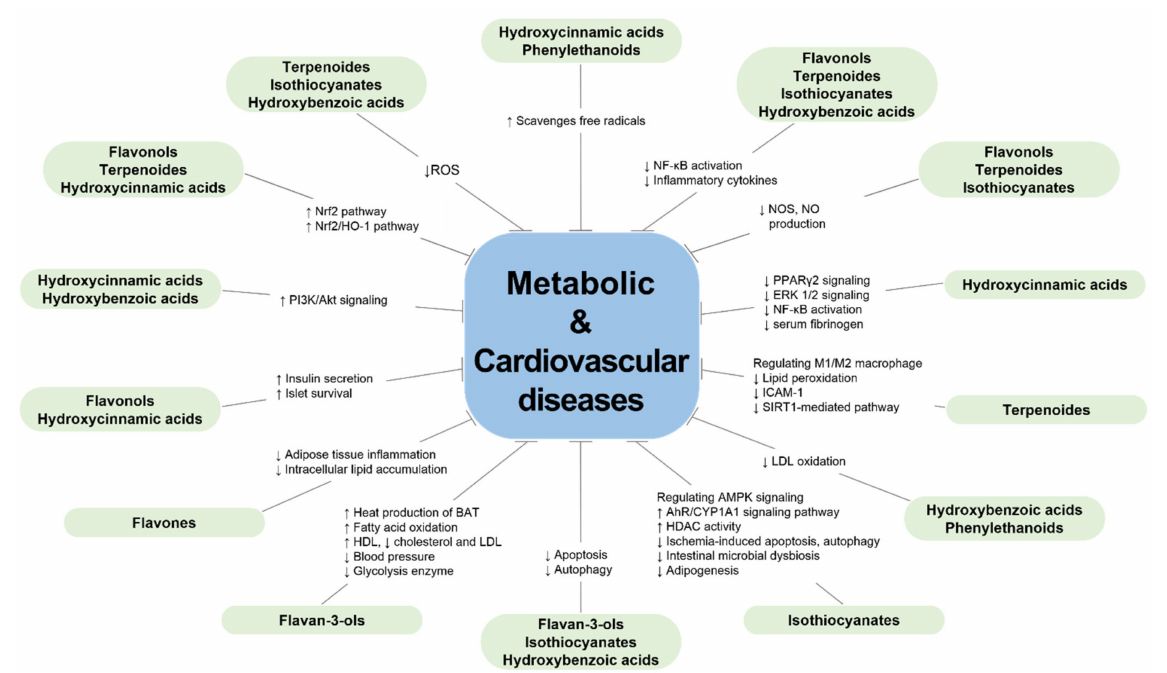
Figure 2. Protective effects of the bioactive compounds from green-colored foods on metabolic diseases and cardiovascular